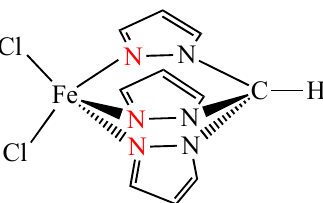
Figure 1. Structure of the C-scorpionate iron(II) complex [FeCl 2 { κ 3 -HC(pz) 3 }] (pz, pyrazolyl).